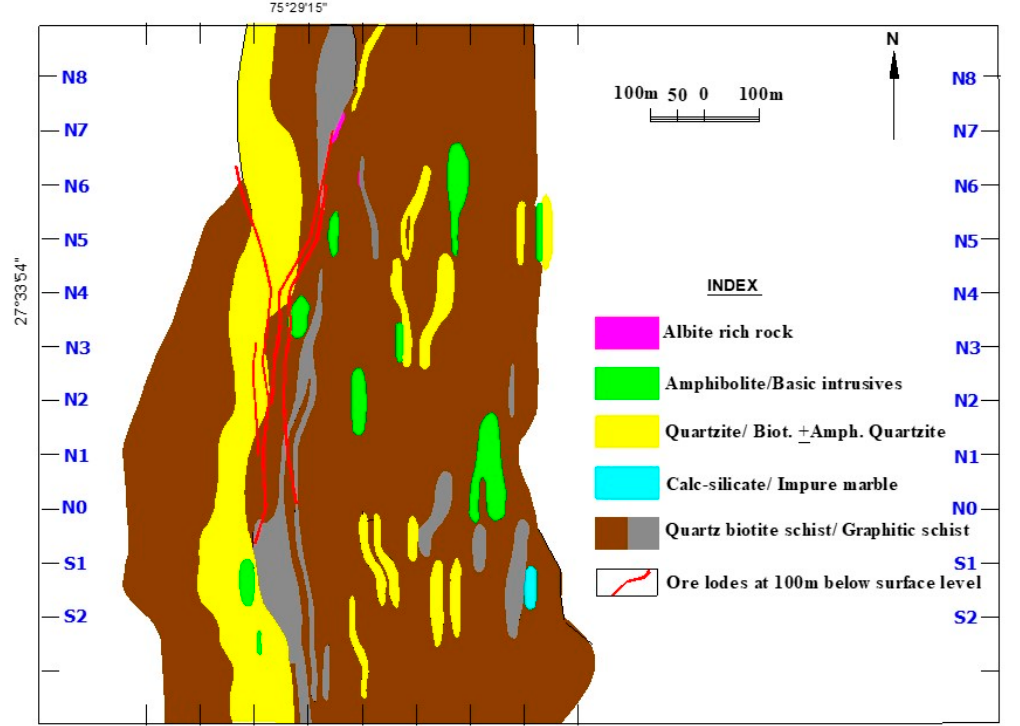
Figure 4. A subsurface geological map of the study area (based on the correlation of borehole inter- cepts).